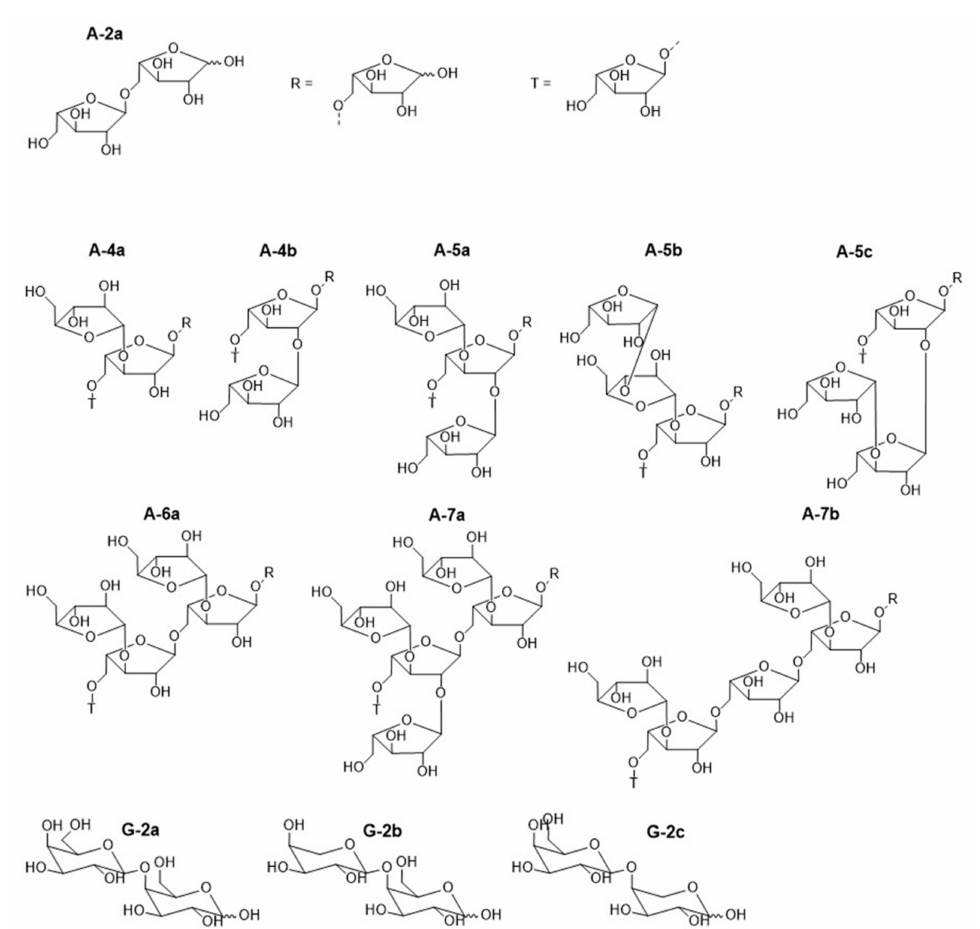
Figure A1. Arabinan and galactan oligosaccharides of IDF and SDF of enzymatically treated apple pomace (raw and extruded) after enzymatic cleavage by endo-arabinanase and endo-galactanase. IDF: insoluble dietary fiber, SDF: soluble dietary fiber, R: reducing end, T: terminal